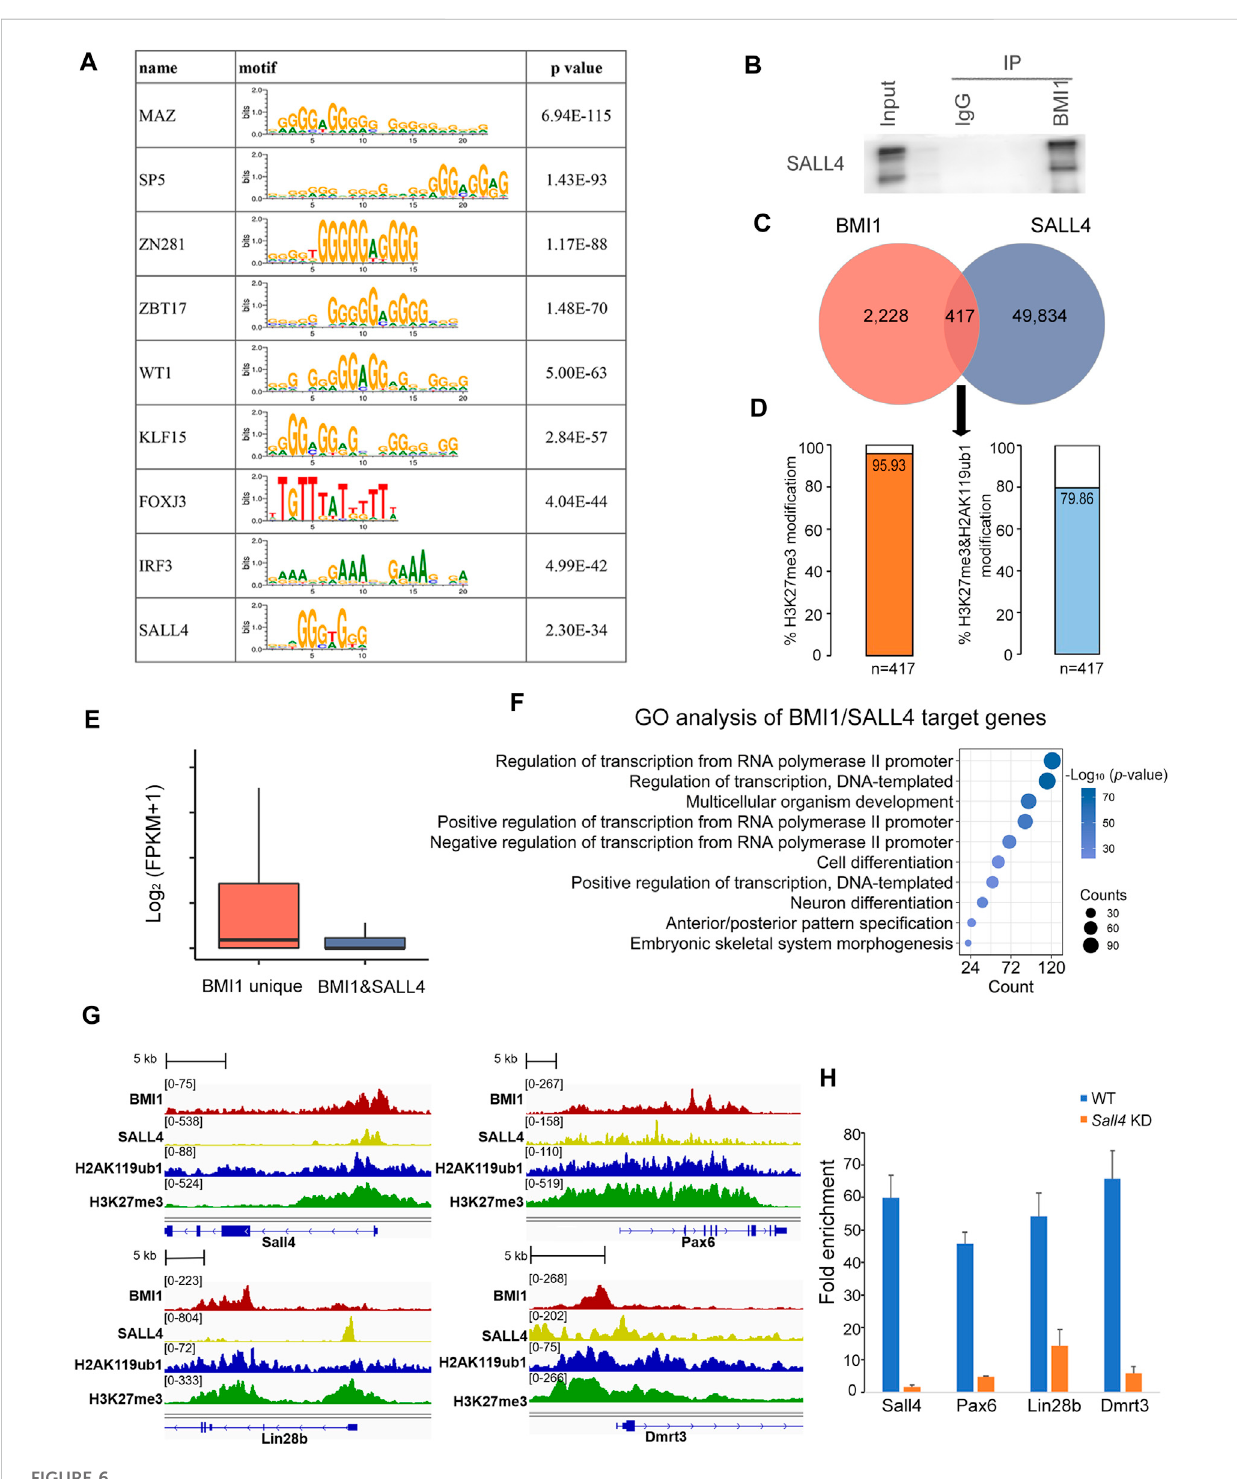
FIGURE 6 BMI1 interacts with SALL4 to work together for gene repression. (A) Motif analysis at BMI1 target regions. (B) Con fi rmation of the interaction of BMI1 and SALL4. (C) Venn diagram shows the overlap among target regions of BMI1 and SALL4. (D) Percentage of BMI1 and SALL4 co-bound genomic regions modi fi ed by H3K27me3 and H2AK119ub1. (E) Box plot represents the gene expression values in BMI1 alone target genes and BMI1/SALL4 target genes. (F) GOanalysisofBMI1/SALL4targetgenes. (G) IGVbrowserviewsforBMI1andSALL4co-targetedgenes. (H) ChIP-qPCRshowsthechanges in BMI1 binding at the selected genomic regions in Sall4 KD cells. Data are showed as means ± s.d. and derived from three independent